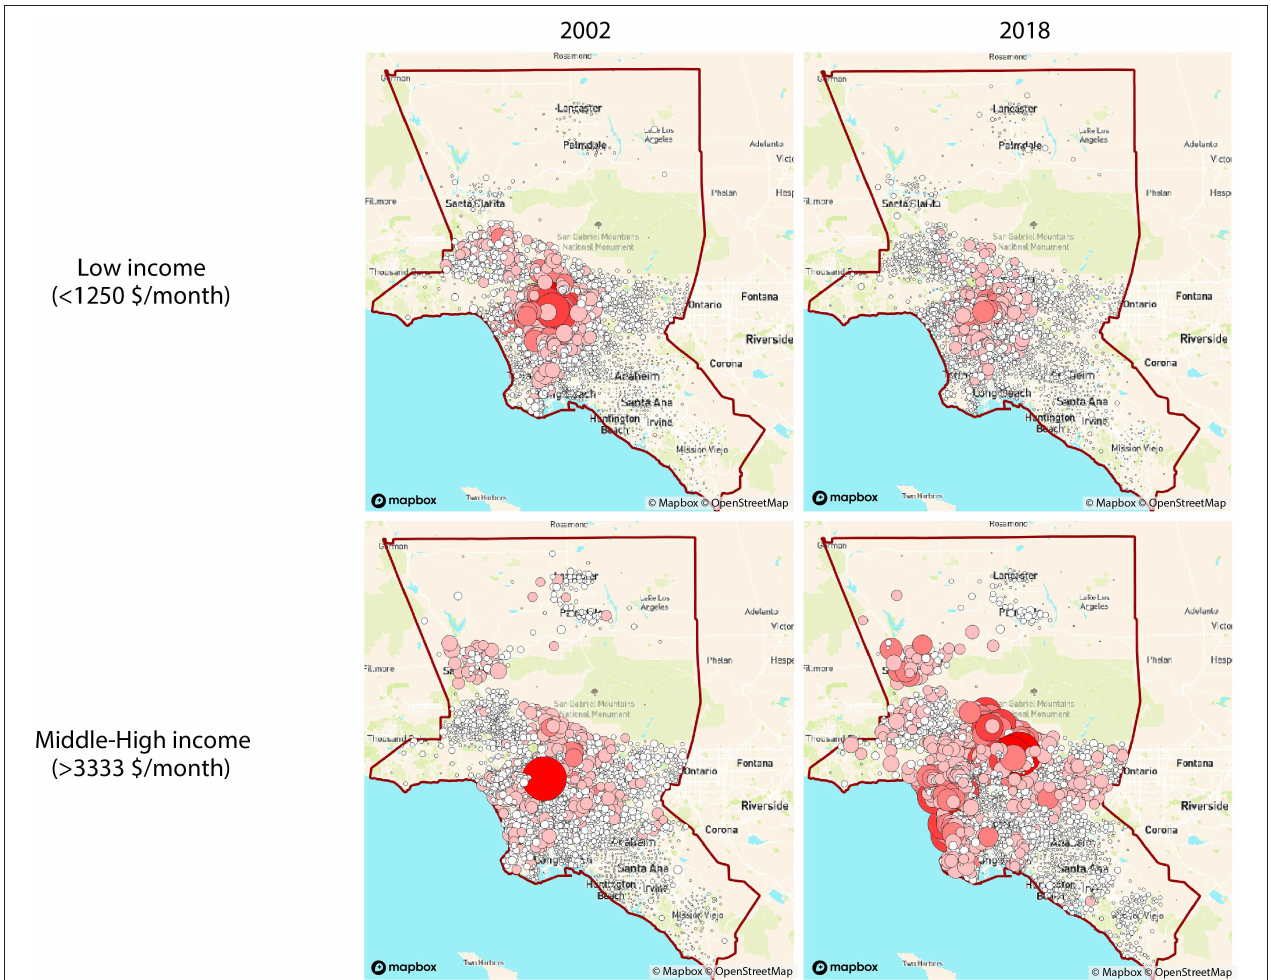
FIGURE 2 | Flow networks of home places of workers commuting to workplaces located in the city centers (around the red circle) based on income groups (weighted out-degree). Node size and color [light (low)-dark (high)] indicates the degree ranking in Los Angeles.